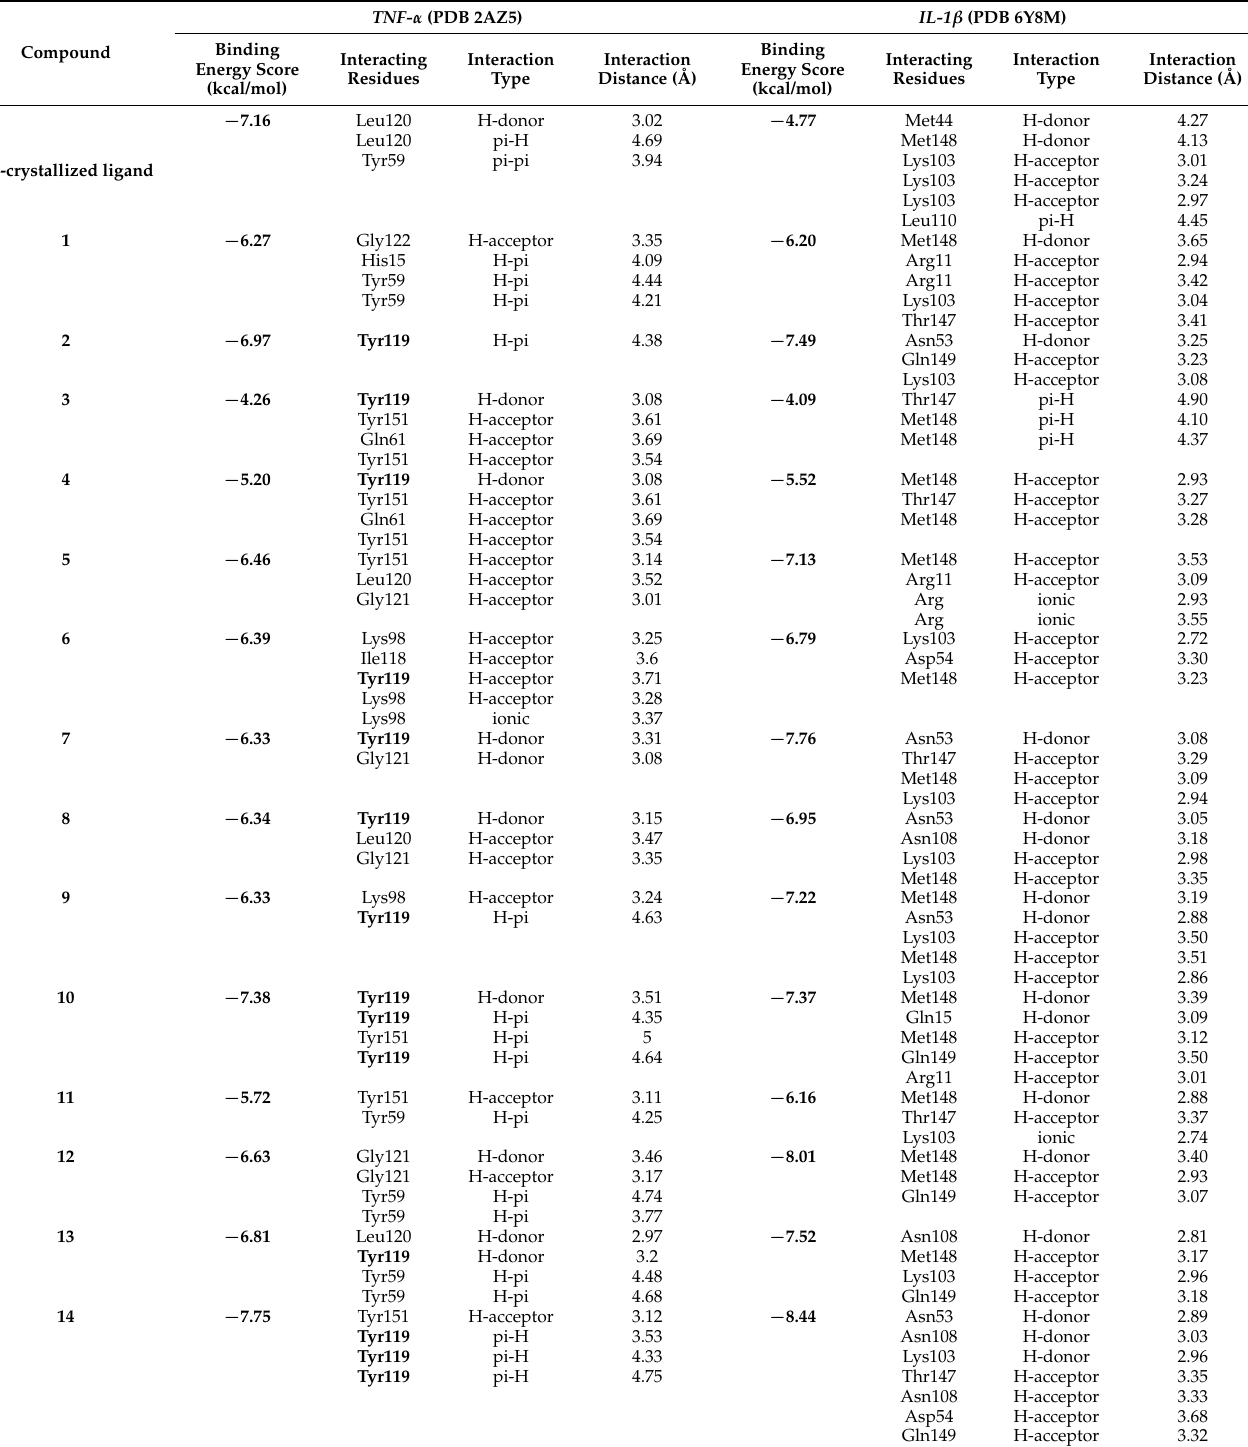
Table 6. The molecular docking results of compounds 1 – 21 using PDB 2AZ5 and 6Y8M for TNF- α and IL-1 β ,